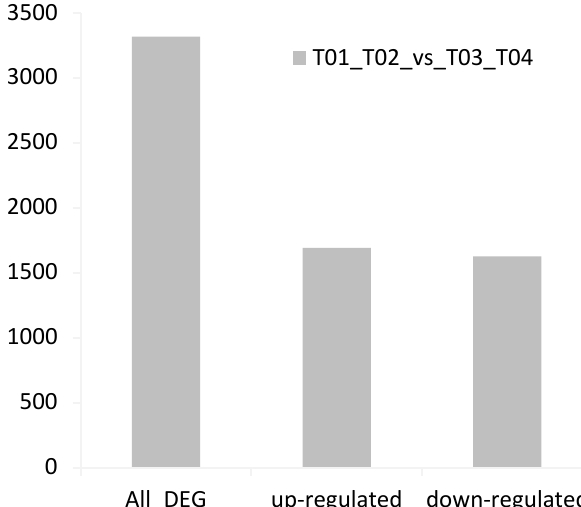
Figure 3. The number of differentially expressed genes. DEG Set: Name of differentially expressed gene set; All DEG: Number of differentially expressed genes; upregulated: TNumber of upregulated genes; downregulated: Number of downregulated genes.